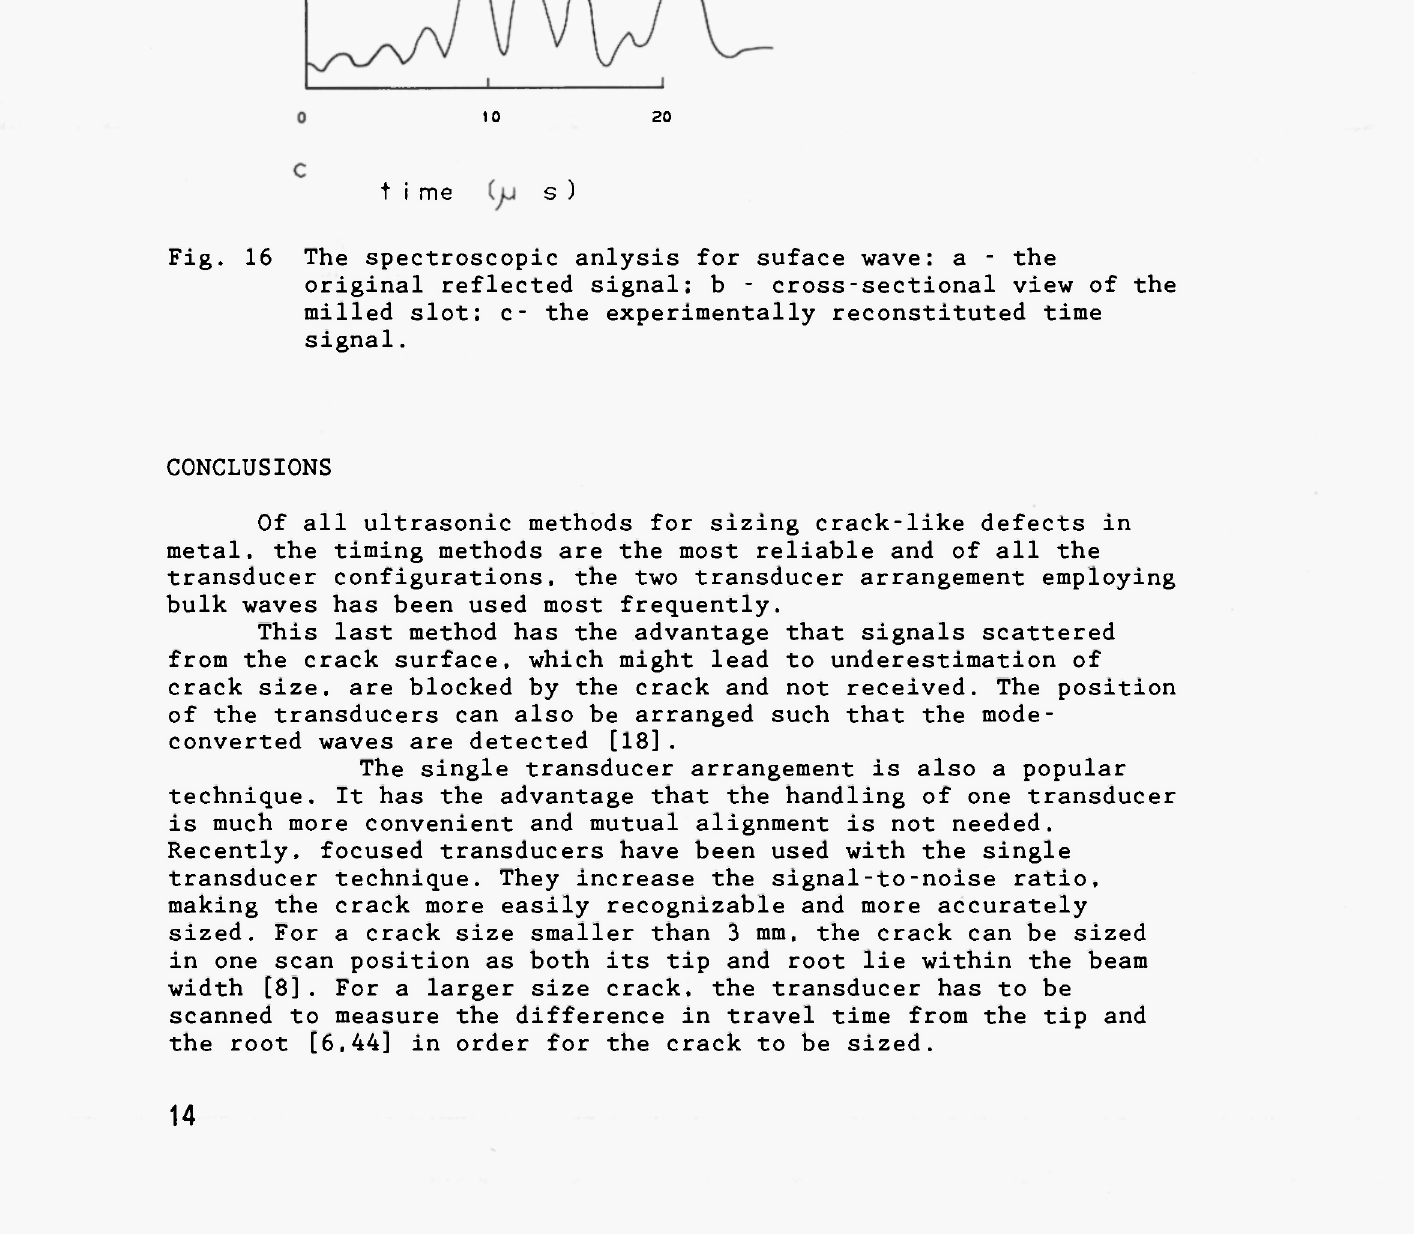
The spectroscopic anlysis for suface wave: a - the original reflected signal: b - cross - sectional view of the milled slot: c- the experimentally reconstituted time